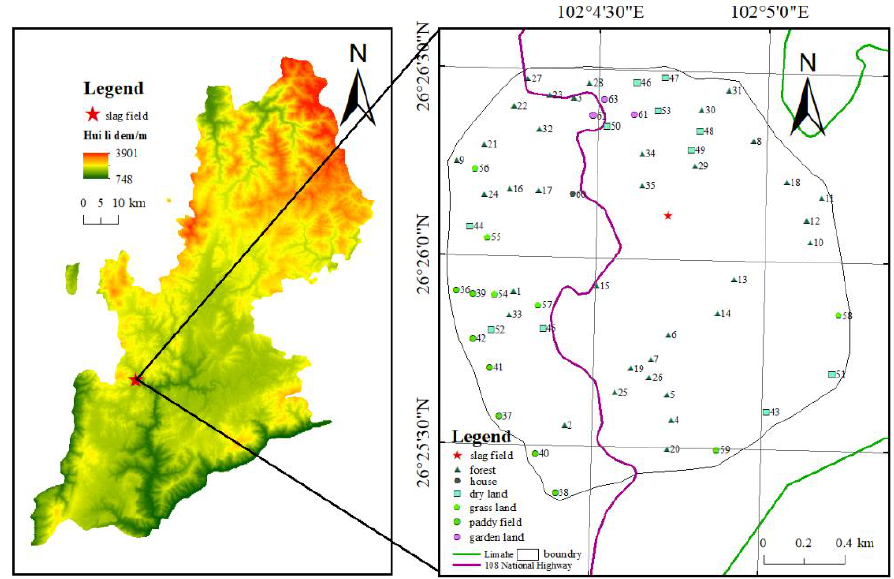
Figure 1. The distribution of sampling sites.